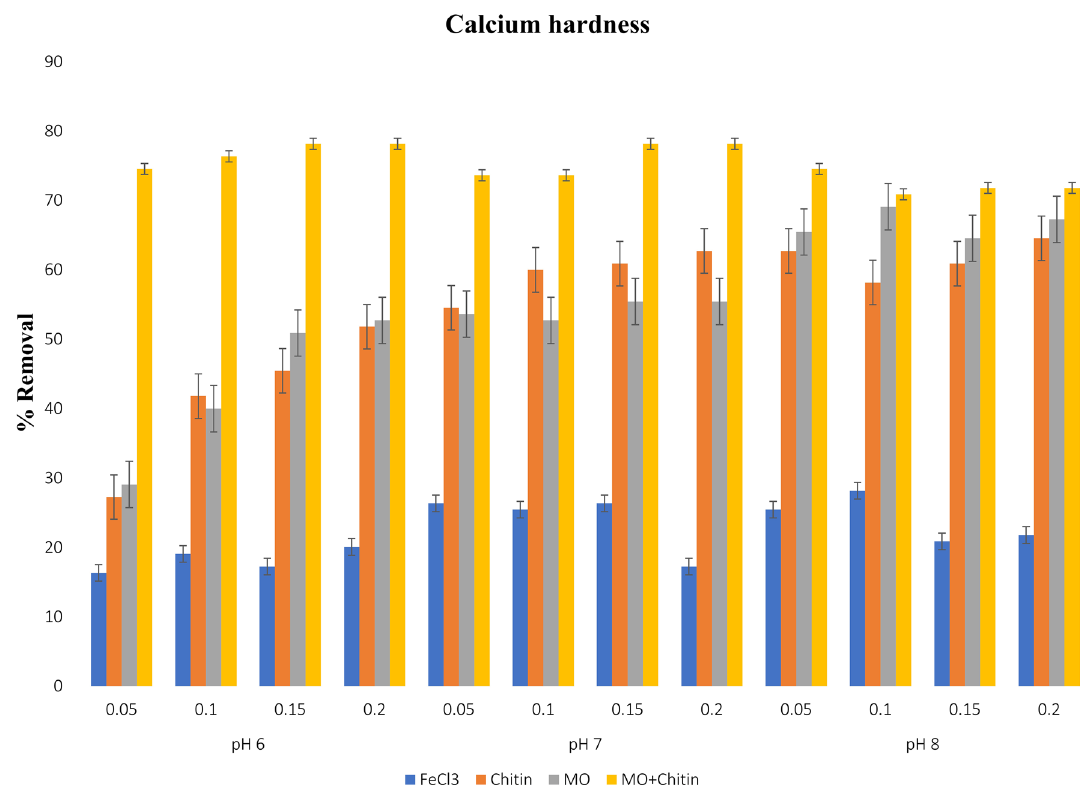
Fig. 6 Calcium hardness reduction by the